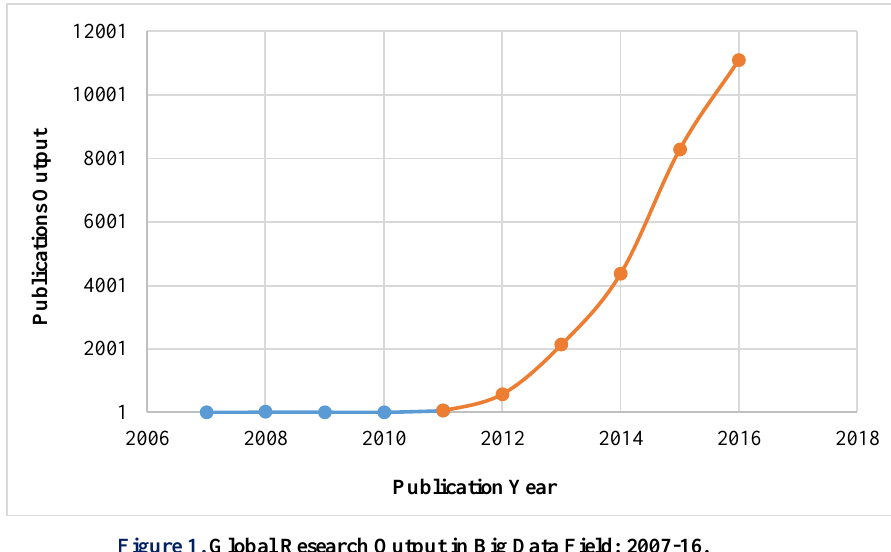
Figure 1. Global Research Output in Big Data Field: 2007-16. Table 1. Global Research Output in Big Data Field: